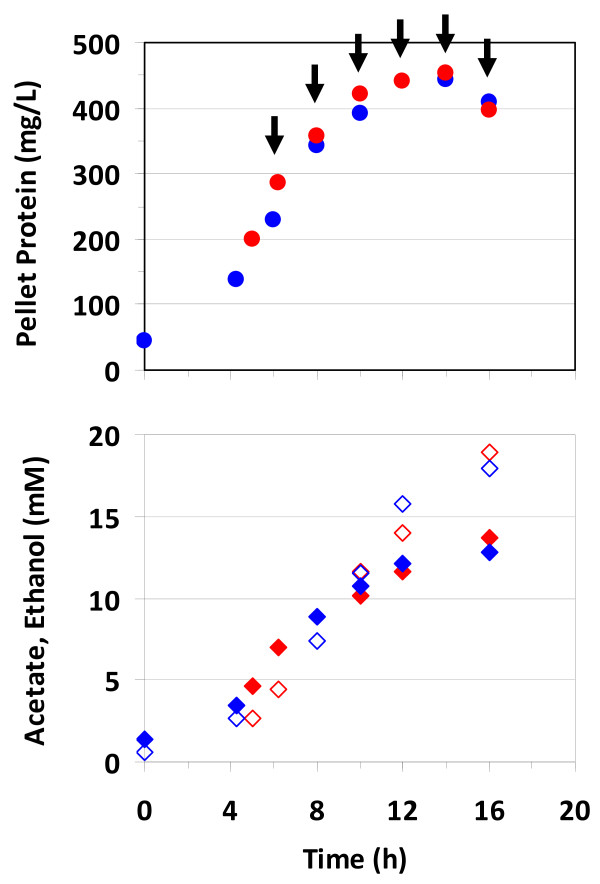
Fermentation growth and metabolite production plots. Pellet protein-based growth and metabolite curves for duplicate Clostridium thermocellum ATCC 27405 fermentations on 5 g/L crystalline cellulose (Avicel®). Arrows in the upper panel indicate culture sampling points for microarray-based gene expression analysis. Acetate and ethanol data in the lower panel are shown in closed and open symbols, respectively.